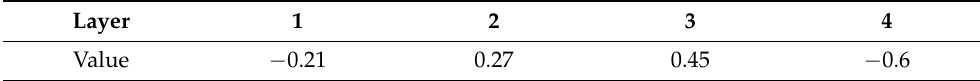
Table 8. The value of the ATE between coaching and student performance in each layer. Layer